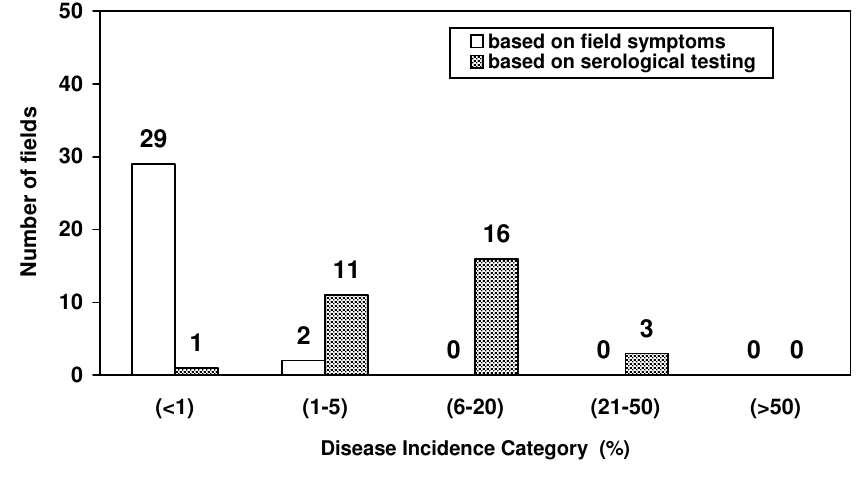
Fig. 3. Comparison between virus incidence in chickpea crop based on symptoms observed in the fi eld and as determined by laboratory testing of randomly collected samples during a survey conducted in Eritrea, November 13–22,